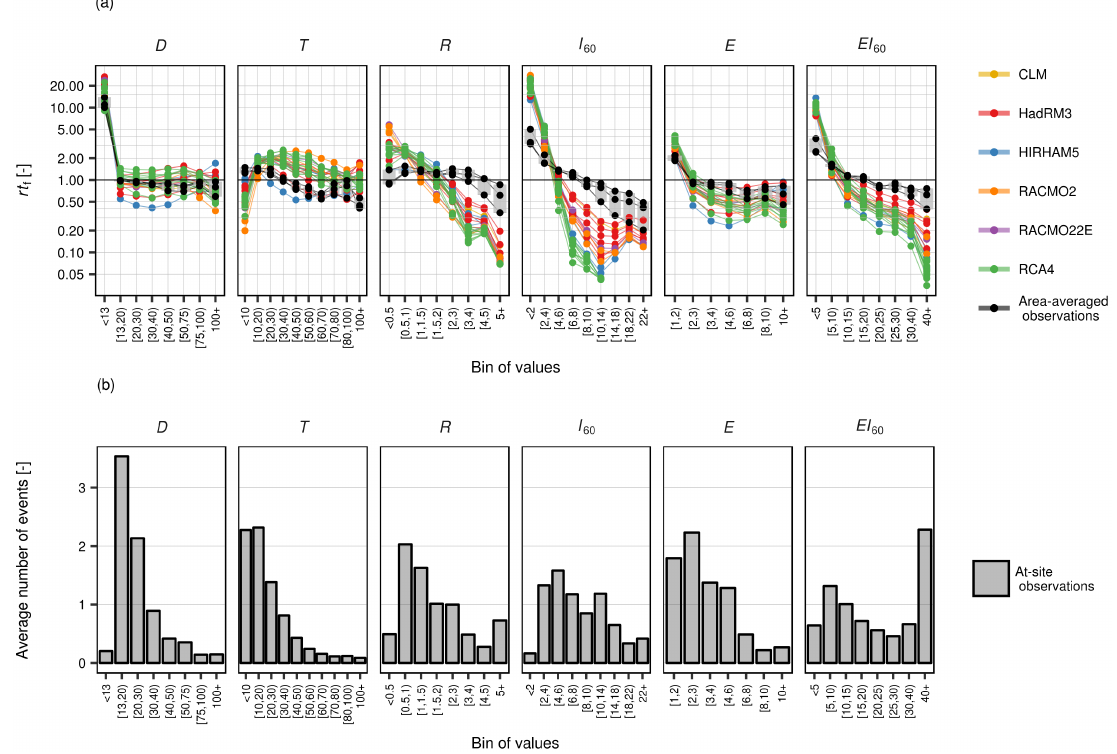
Figure 5. (a) Histogram ratios rt f between areal and station average of frequencies of corresponding bins of the histograms of rainfall event characteristics. Frequencies of bins are averaged per individual season and grid box for the RCM simulations (or neighbourhoods for area- average observations). Grey bars highlight ranges between the 12.5, 25, and 50km area-average observations (black dots). (b) Histograms of the number of at-site events averaged per individual season and individual station. Units of characteristics defining bins of values are mm ( D ), h ( T ), mmh − 1 ( R , I 60 ), MJha − 1 ( E ), and MJmmha − 1 h − 1 (EI 60